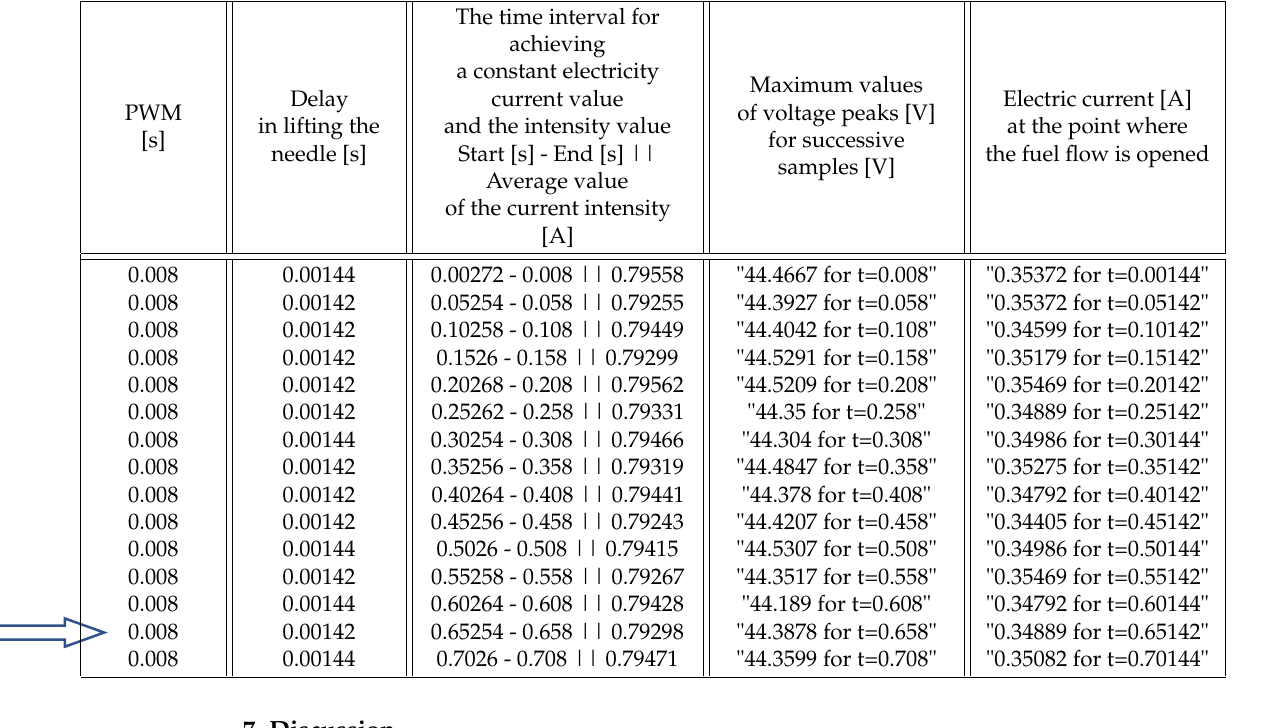
Table 3. User panel filled with selected values—exp. II—4 ms, 0.4 MPa.